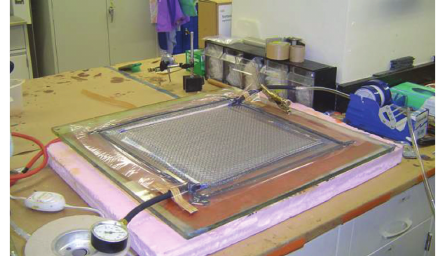
Figure 1: H-VARTM© setup.